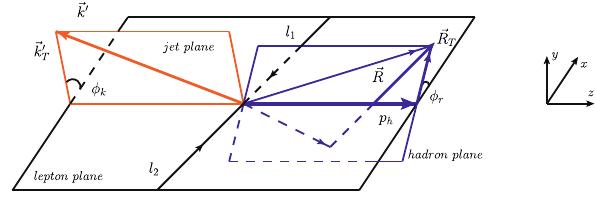
Fig. 2 Kinematics for the e + + e − → h 1 + h 2 + ¯ q + X